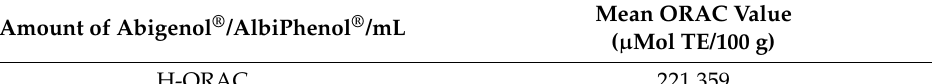
Figure 5. TEER values before the treatment (pre-treatment), after exposure to digestive fluids (DF) or digested Abigenol ® /AlbiPhenol ® (post-treatment) for 1 h ( A ) and 3 h ( B ) and after 24 h of recovery. Values are expressed as a percentage of the pre-treatment TEER value (n = 3). Table 3. Mean ORAC values calculated as micromoles of Trolox equivalents per 100 g of formulation ( µ mol TE/100 g) on both the hydrophilic (H-ORAC) and the lipophilic (L-ORAC) fractions of the formulation. Total-ORAC represents the sum of H-ORAC and